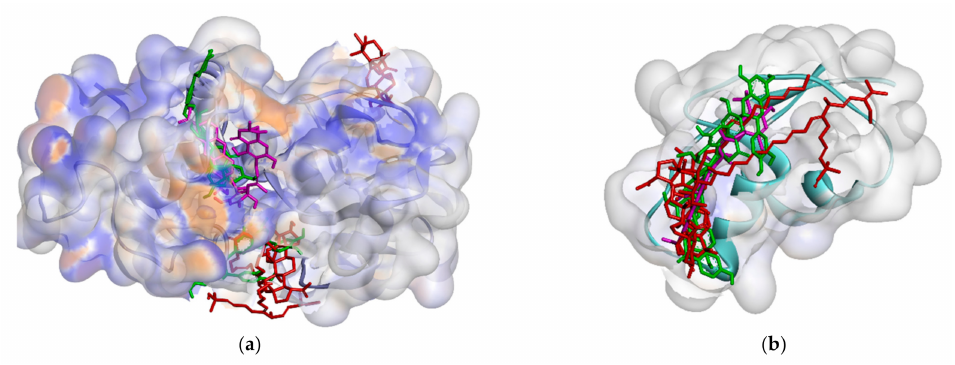
Figure 6. Ligand positions in protein ribosomal subunit 30S ( a ) and ribosomal subunit 50S ( b ). Among all ligands, compound 2 is the strongest compound that binds to